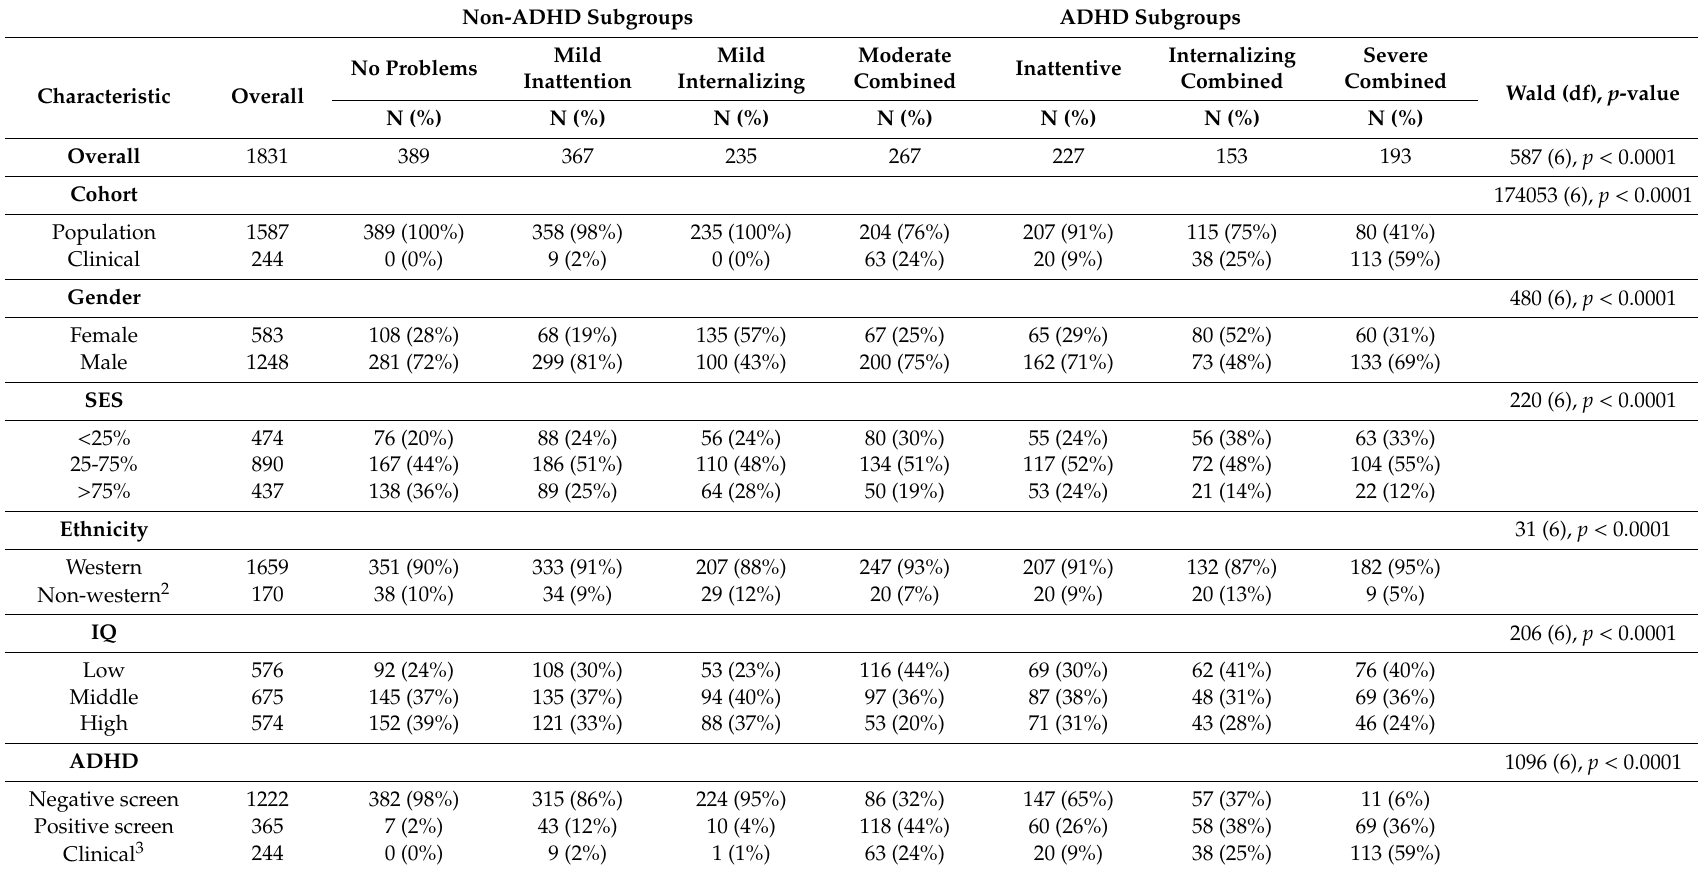
Table 1. Characteristics of the seven subgroups 1